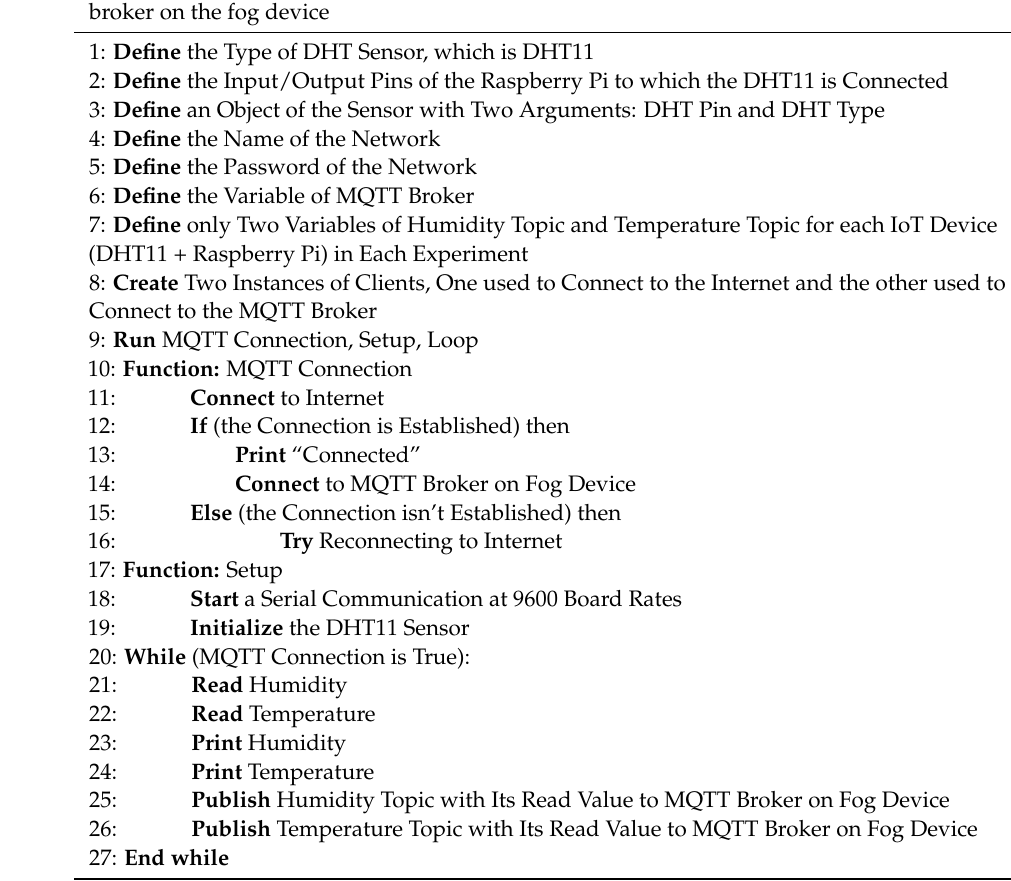
Algorithm 1. Gather data generated from the IoT device and forward it to the fog node. First architecture/*. This algorithm authenticates the IoT device to the fog device, generates temperature and humidity data via DHT11 sensors, and publishes them to the Mosquitto MQTT